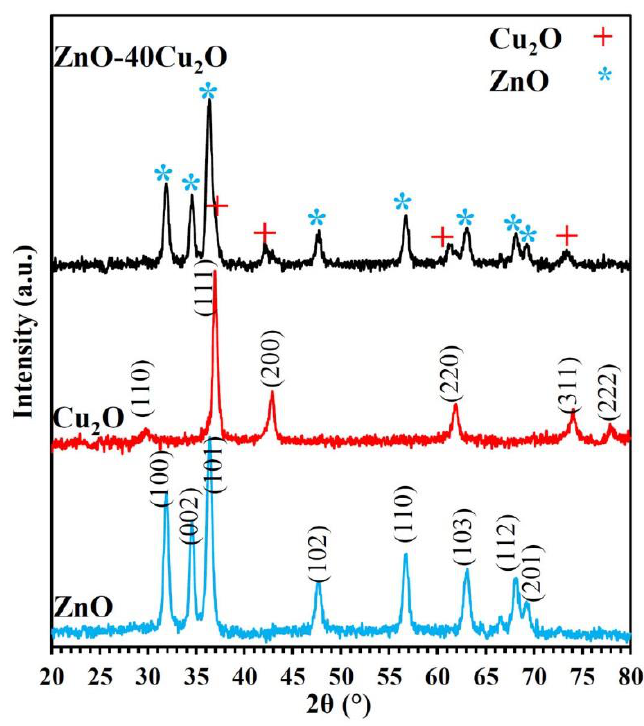
Fig. 1. XRD patterns of the prepared